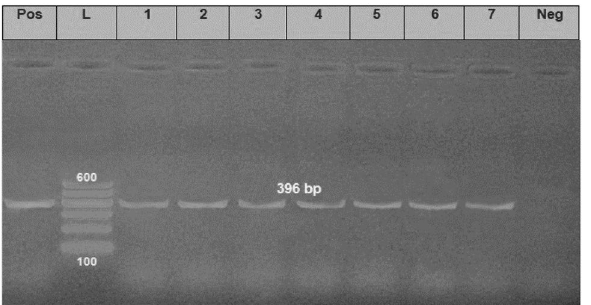
Figure 4. Electrophoretic pattern of primers targeting tox A gene. Lane L: 100 bp molecular weight ladder (Fermentas, Thermo Scientific, Germany); lane Pos: the positive control (Reference strain from Animal Health Research Institute in Dokki, Cairo, Egypt), and lane Neg: the negative control (template without DNA). Lanes 1–7: the specific DNA product (396 bp) amplified from representative isolates of P. aeruginosa .